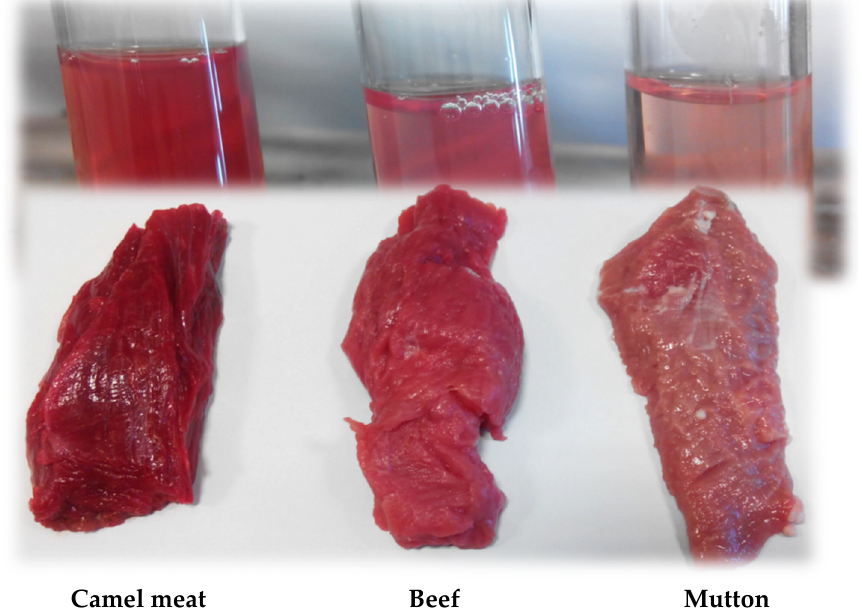
Figure 5. A picture showing meat chunks from camel, beef and mutton and their extracted haem pigments. ments.